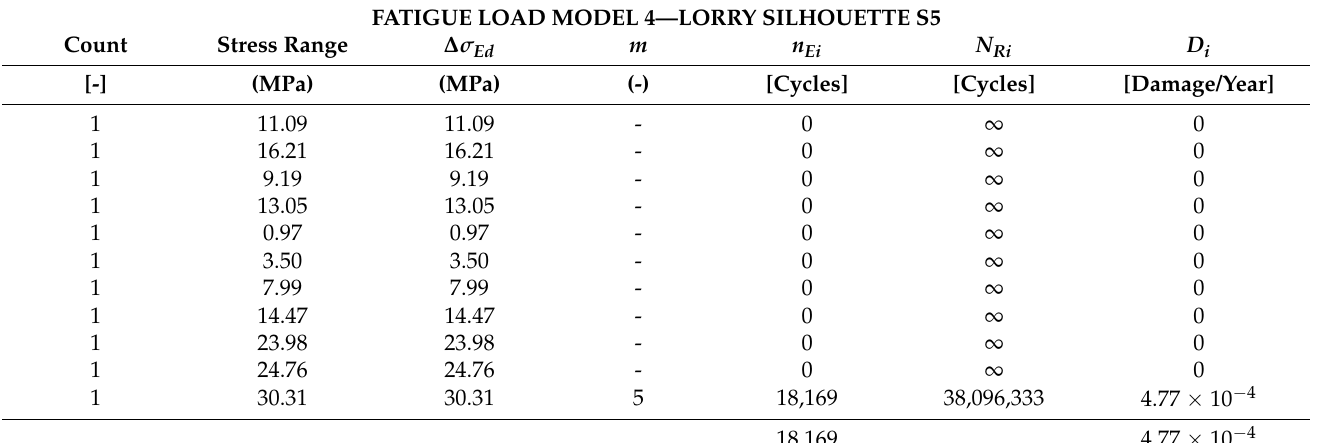
Table 8. Distinction of detail assessment: Rib-to-Plate—FLM4 S5.